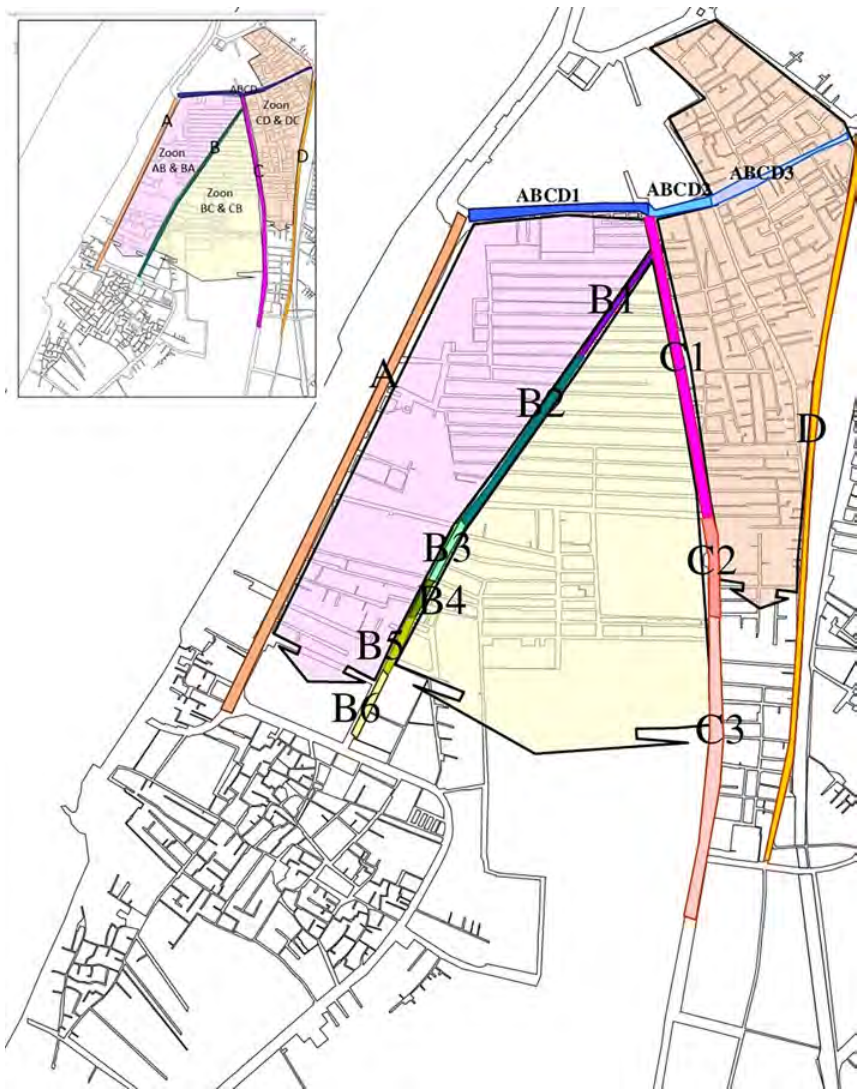
Figure 3. Luxor’s south district and its